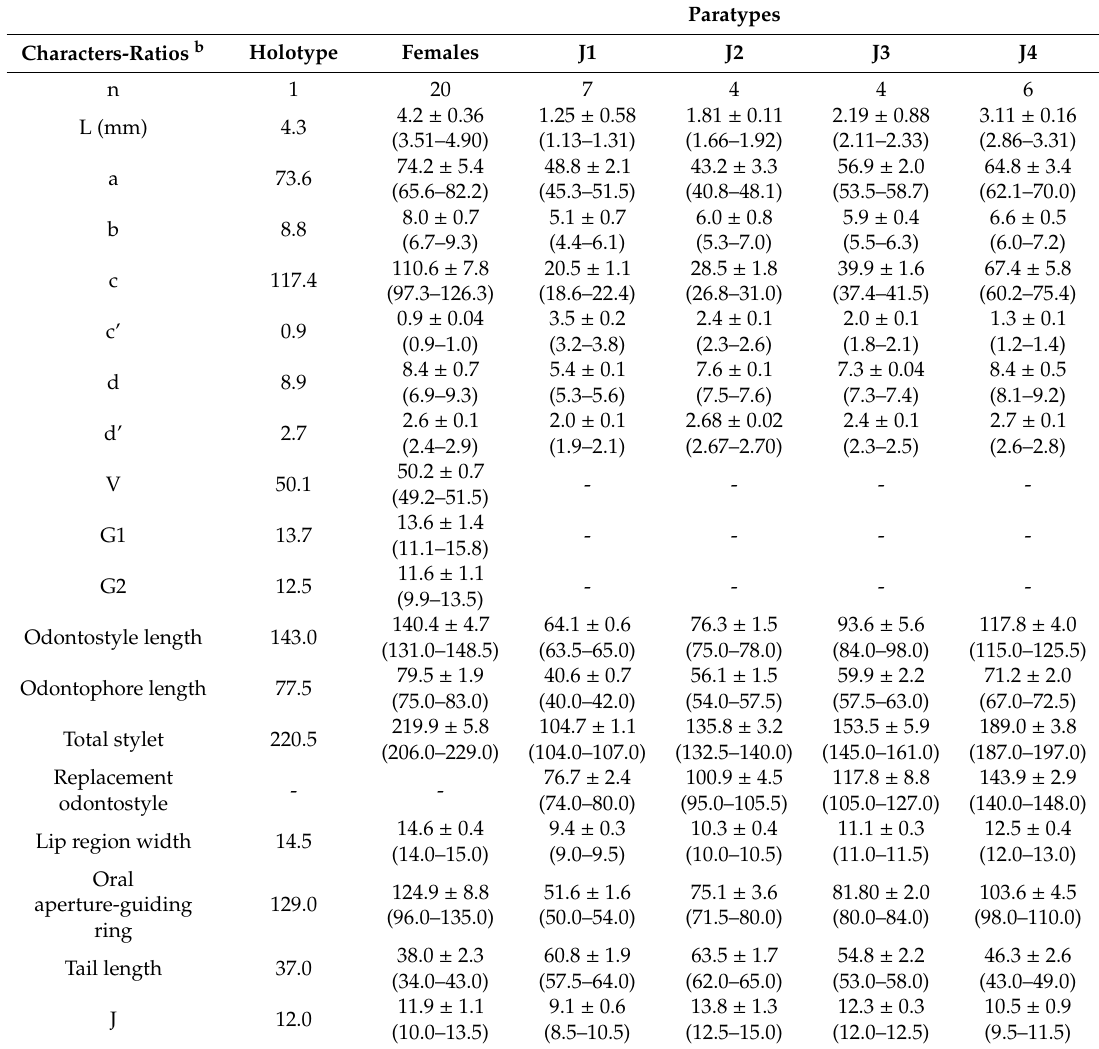
Table 3. Morphometrics of paratypes for Xiphinema malaka sp. nov. from maritime pine ( Pinus pinaster Aiton) at Canillas de Albaida (M á laga province) southern Spain a